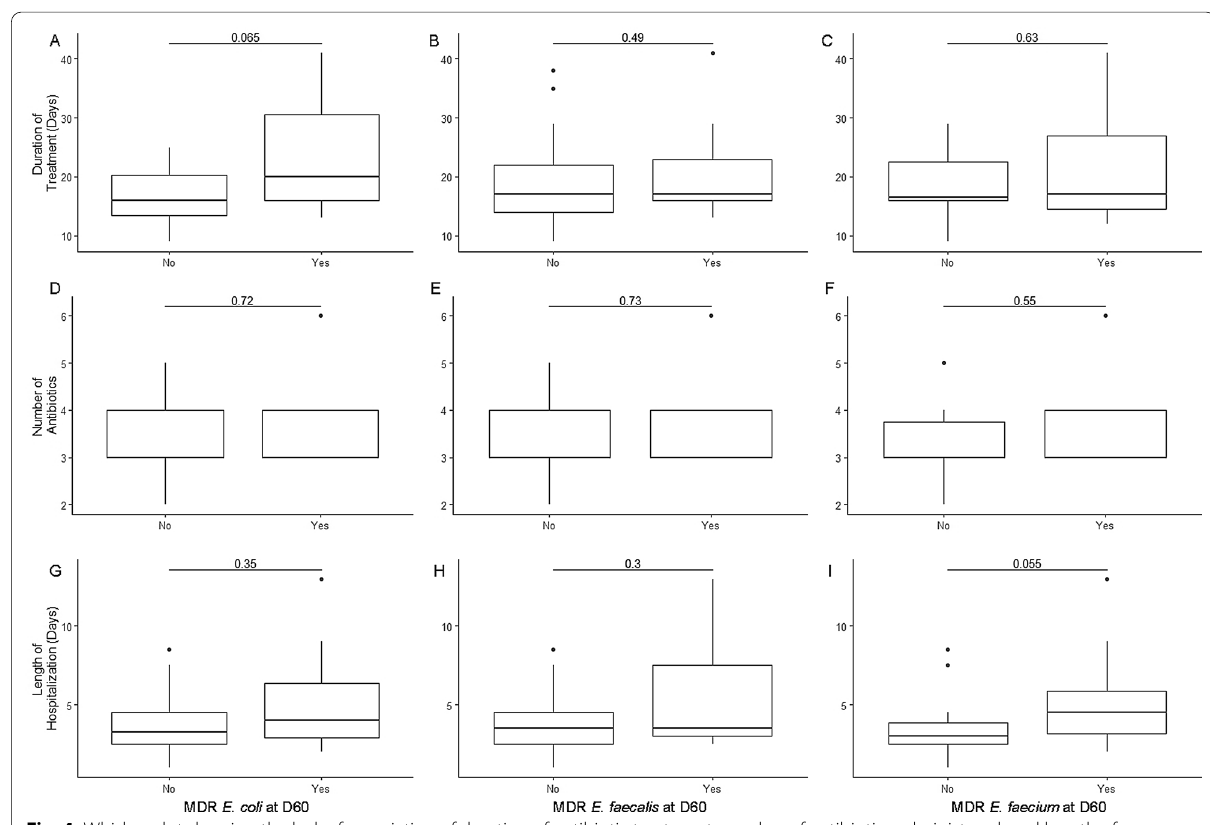
Fig. 4 Whisker plot showing the lack of association of duration of antibiotic treatment, number of antibiotics administered, and length of hospitalization in relation to dogs with and without a MDR E. coli , E. faecalis , or E. faecium at D60 with Wilcoxon rank sum test P